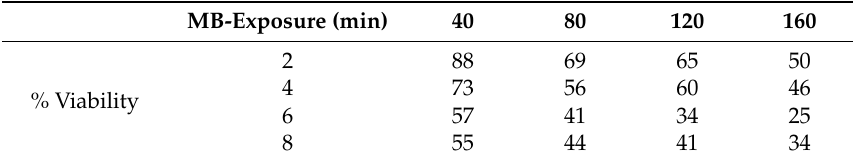
Table 1. Time and concentration ( µ M) dependent toxic effects of methylene blue (MB) on Detroit 562 cells, in percentage of viable cells rounded to integer values. MB-Exposure